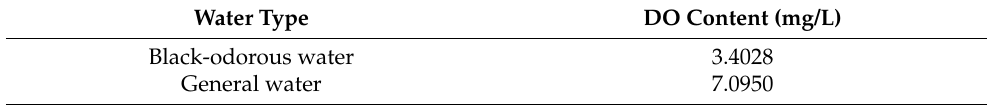
Table 3. DO content of black-odorous water body and general water.